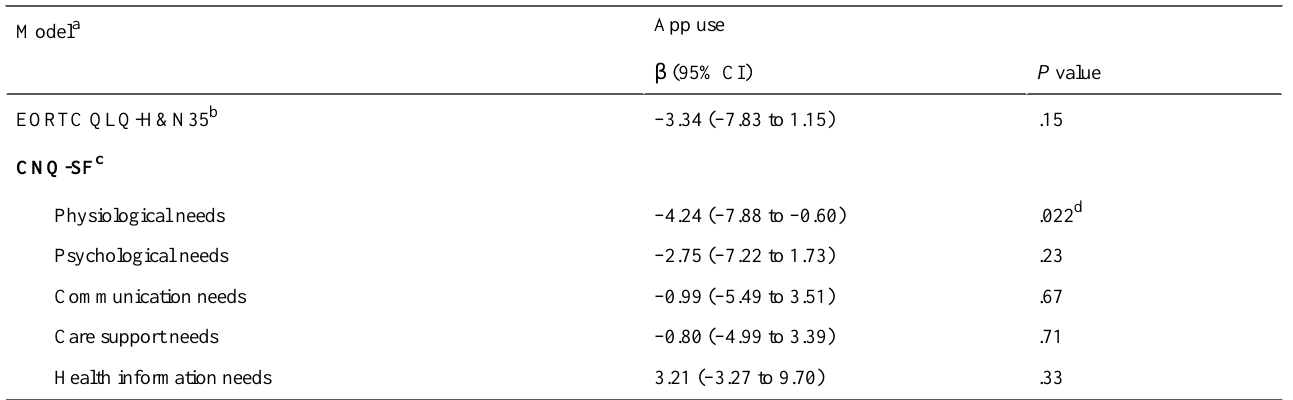
Table 4. Multivariate linear regression analysis of patients’care needs after the mHealth app